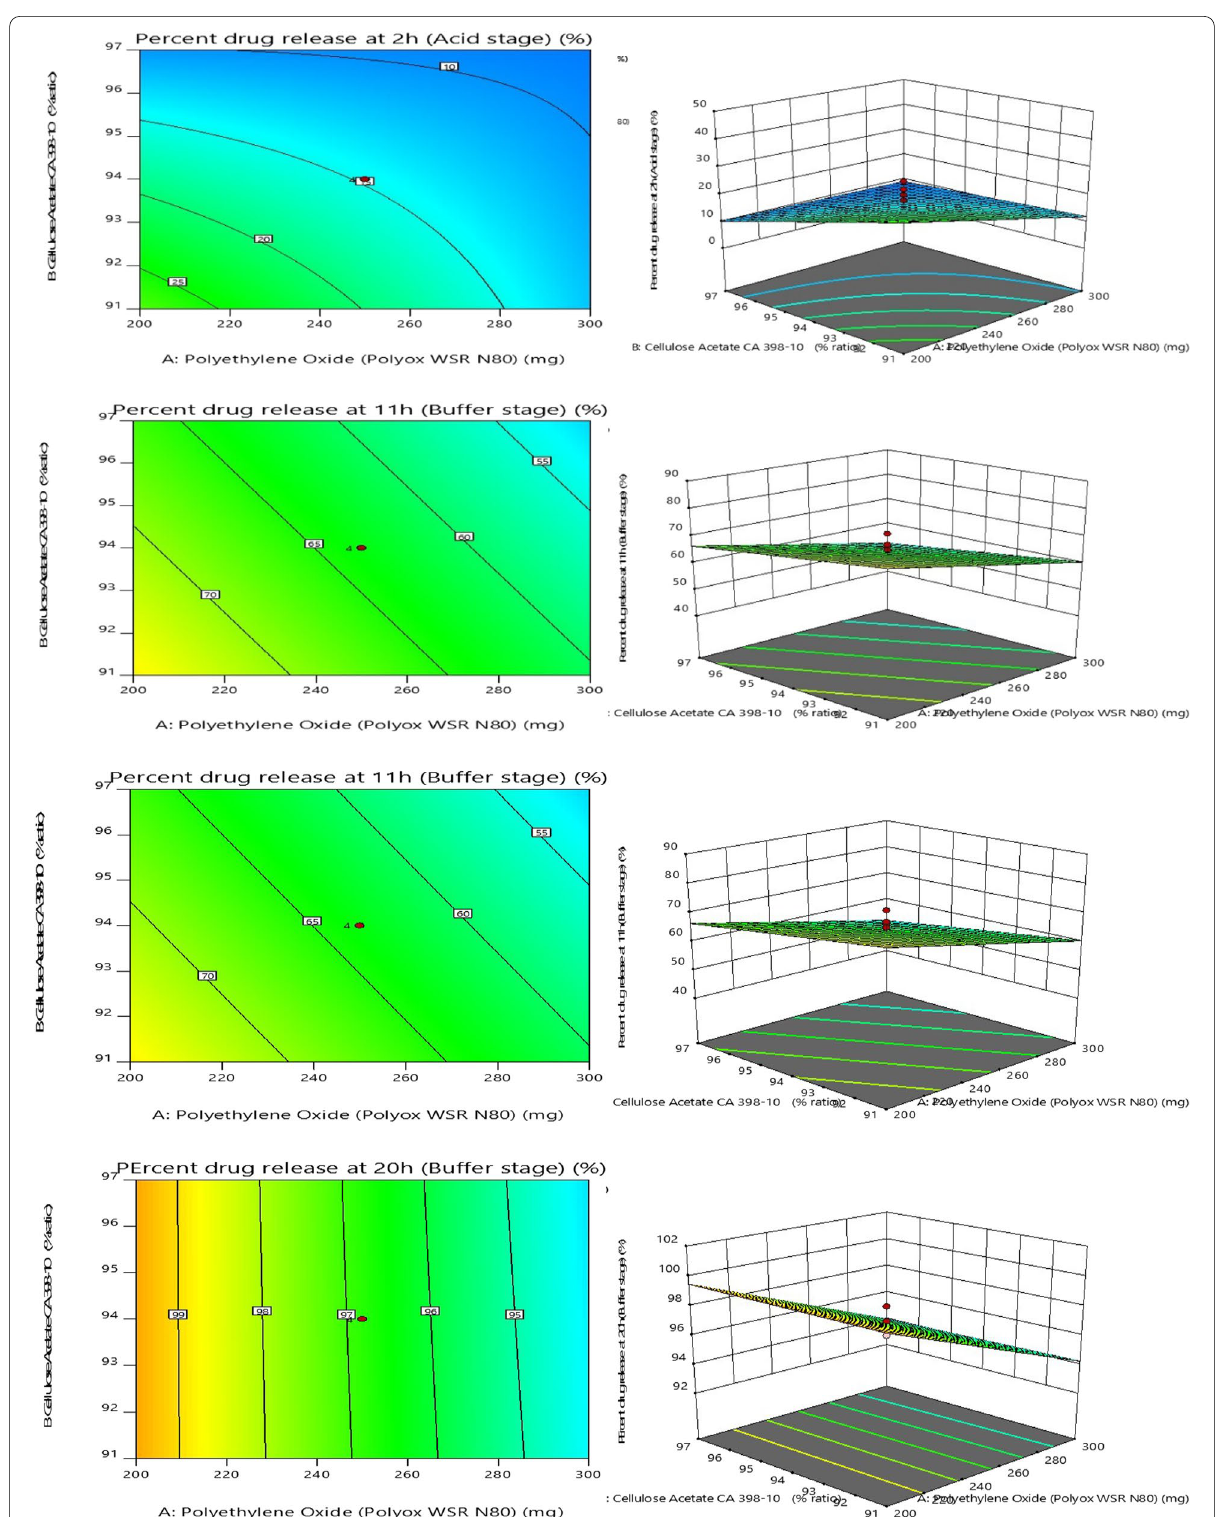
Fig. 3 Percent drug release at 2 h (Acid stage), 5 h, 11 h, 20 h (Buffer stage) showing Contour plot and Response surface